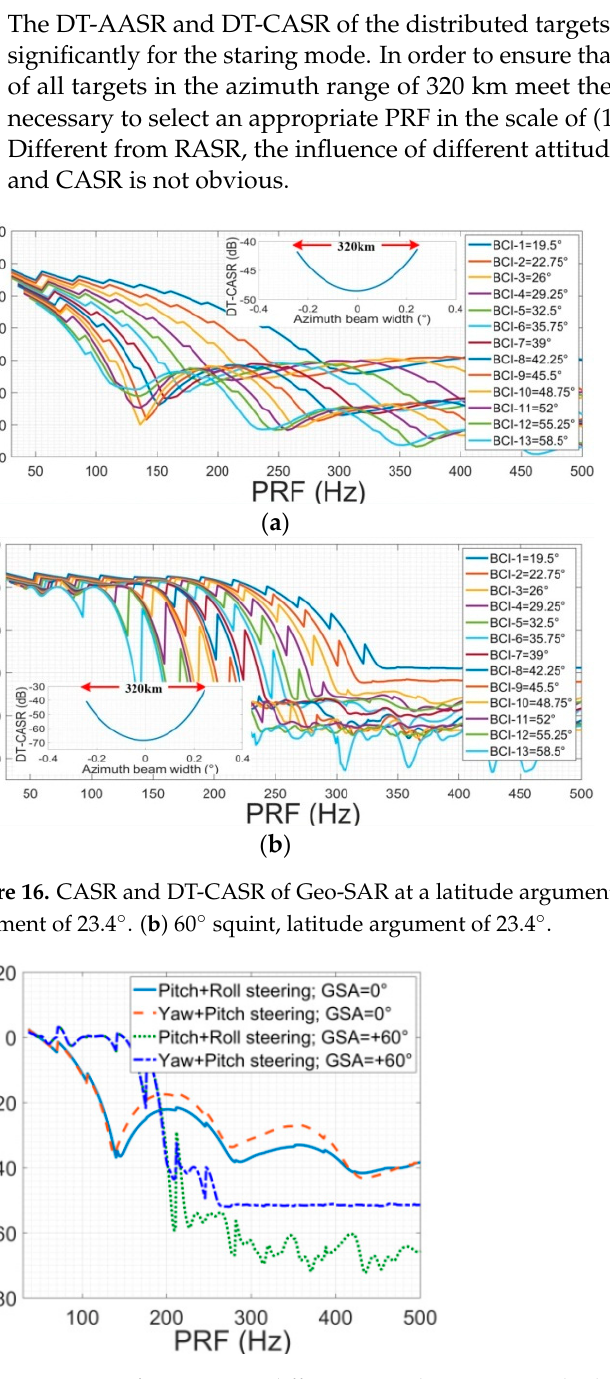
Figure 17. CASR of Geo-SAR in different attitude steering method conditions at a latitude argu- ment of